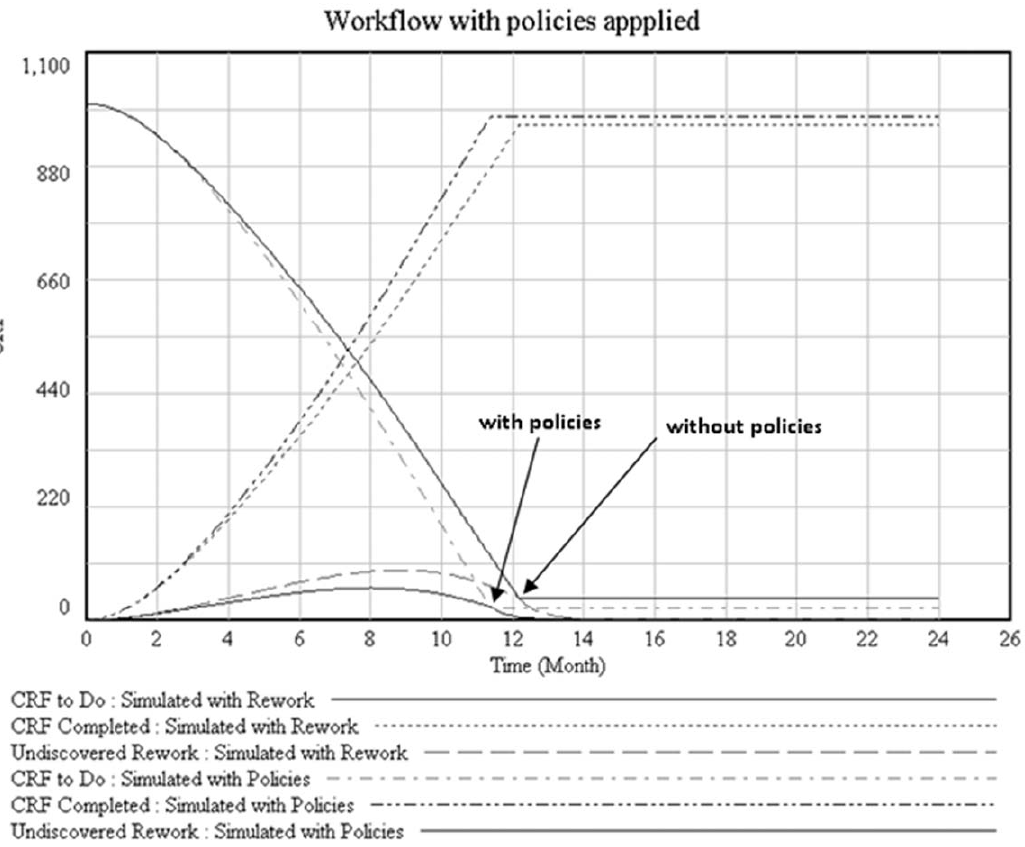
Figure 4. CRF’s to do and CRF’s completed in two situations: simulated with rework and simulated with policies suggested.